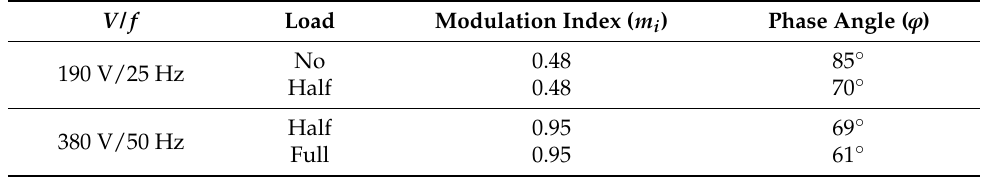
Table 1. Operation conditions.